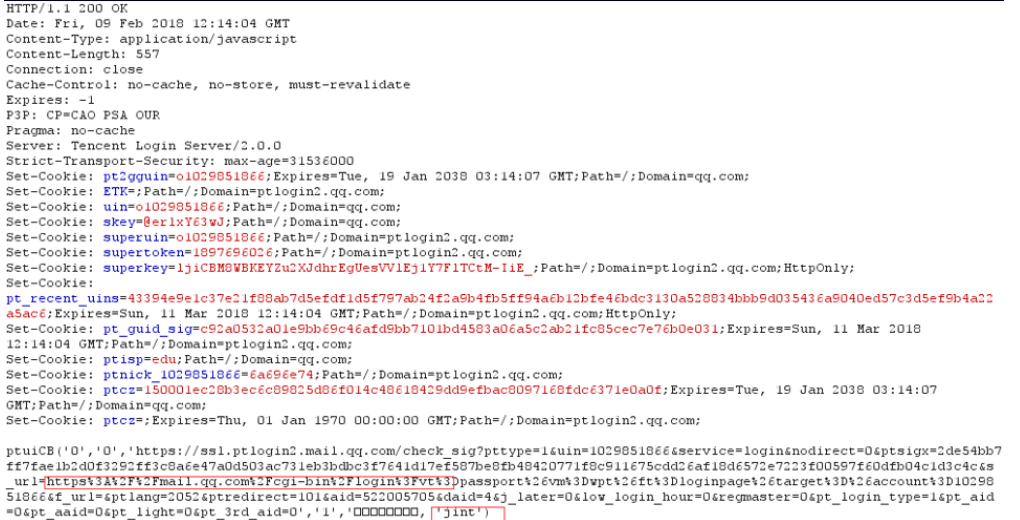
Figure 30. Generated model of the QQ mail system server-side. As shown in Figure 30, intuitively, firstly, the value of p in the constructed message was decrypted when the server received the constructed messages. Then, the MD5 values in sequences of p were verified. Finally, the server generated response messages and sent those to the client. Therefore, from Figure 30, we are convinced that Tencent QQ mail system version of 2017 will verify the encrypted and hashed sequences of the user password at its server-side. Furthermore, we combined the constructed messages, the corresponding response message sent by the server, and the server-side abstract model and we found that Tencent QQ mail system version 2017 has other strong security restrictions for login attempts at server-side besides security checks for user password, such as check valid session time and the times of login attempts. In our test, the server directly returned some warning messages, such as “login timeout”, “too many error logins, please try later”, and so on. Apart from that, the server updated the verification code when there were many login attempts with constructed request messages in a certain time window.